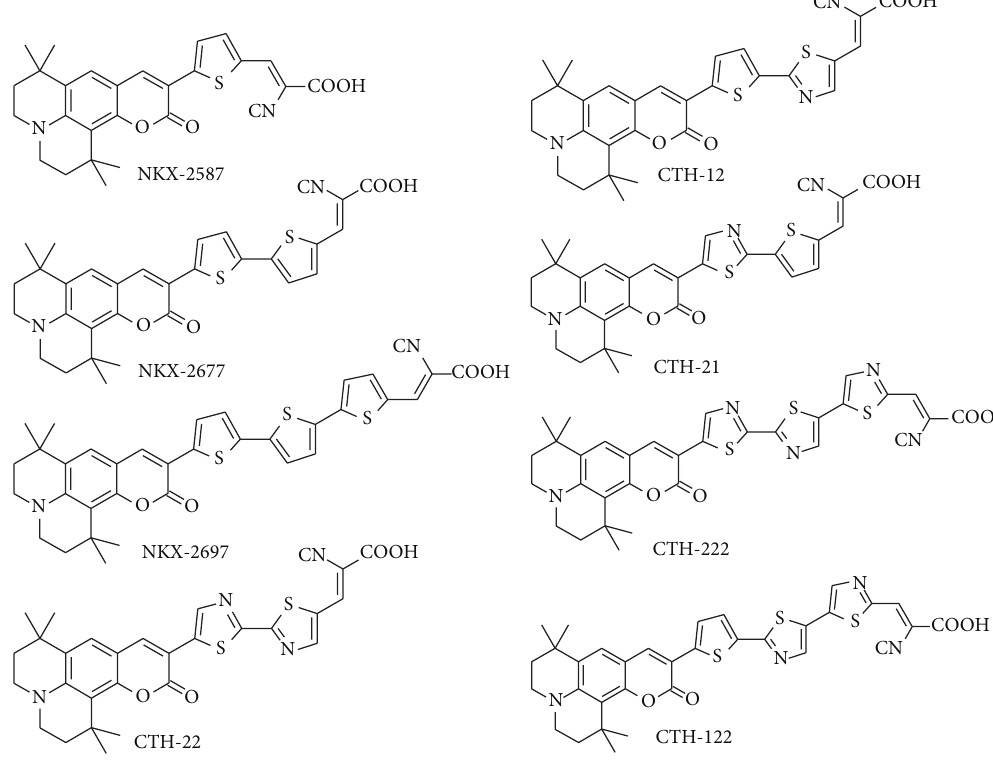
Figure 1: Coumarin derivative dye